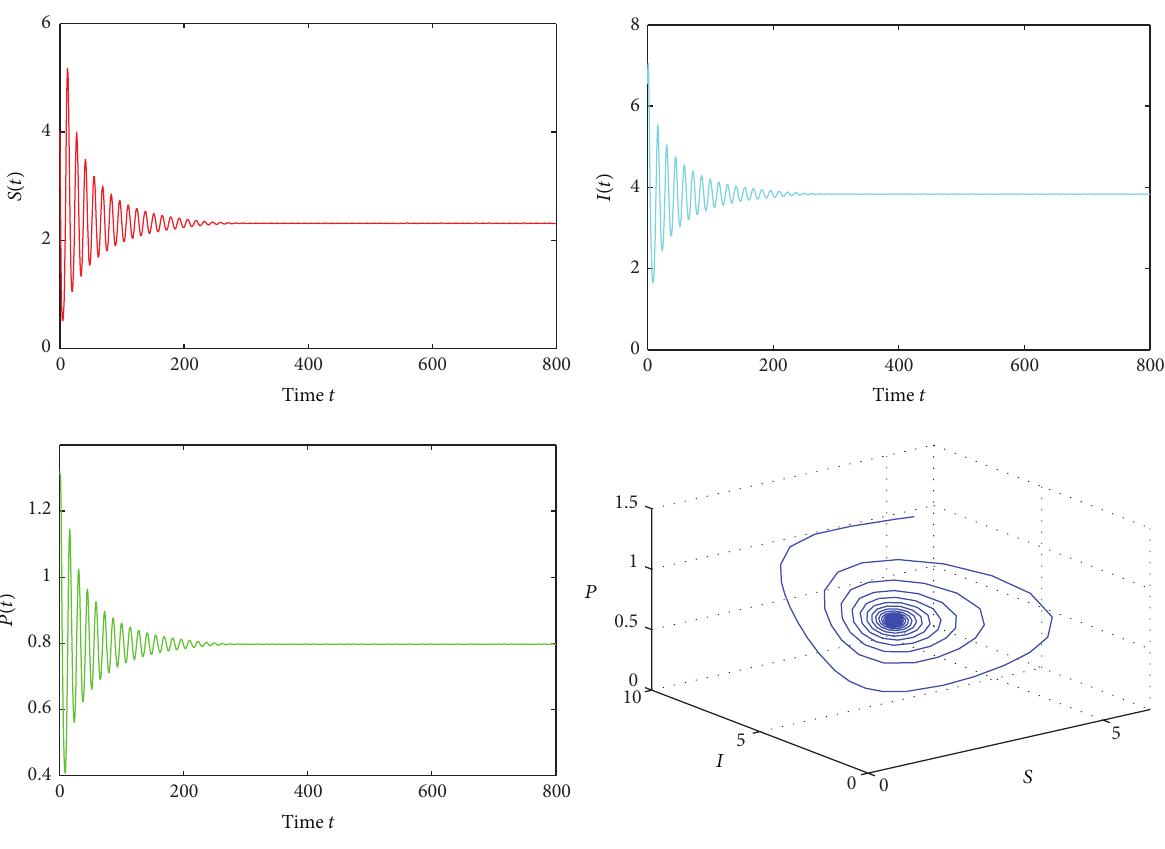
Figure 3: 𝐸 ∗ is asymptotically stable when 𝜏 2 = 1.275 < 1.8829 = 𝜏 20